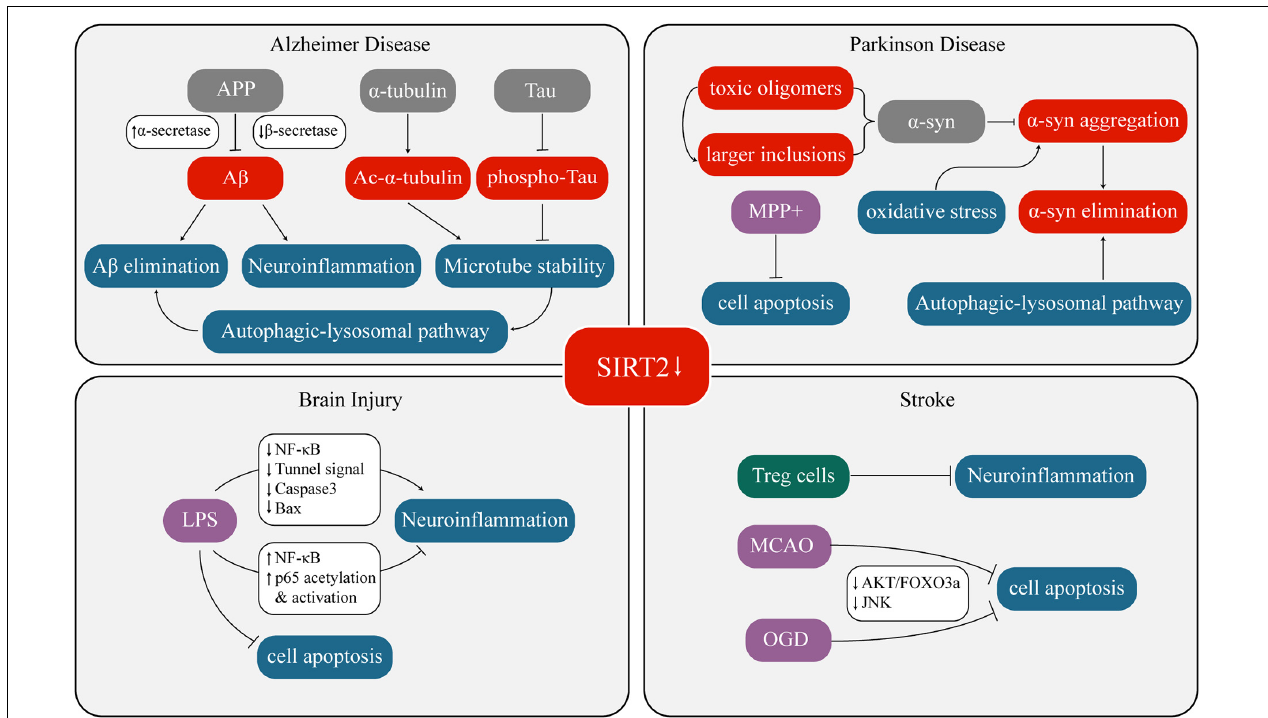
FIGURE 1 | Crosstalk between SIRT2 and neurological